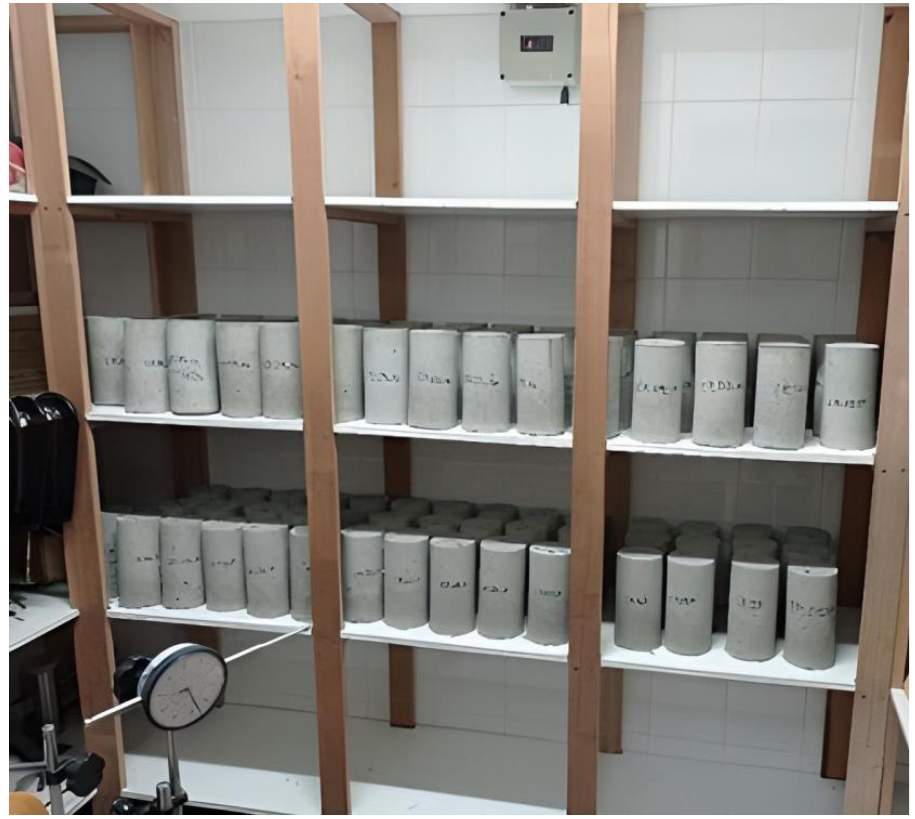
Figure 2. Mechanically treated ends ’ specimens stored in the climatized chamber.